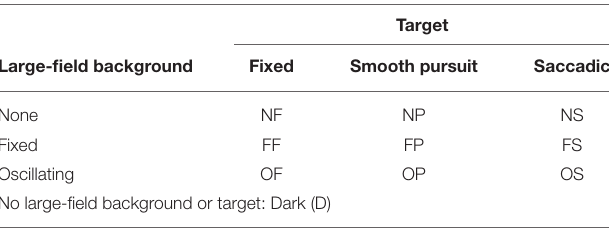
TABLE 1 | Letter codes denoting combinations of large-field background and target state used to identify visual